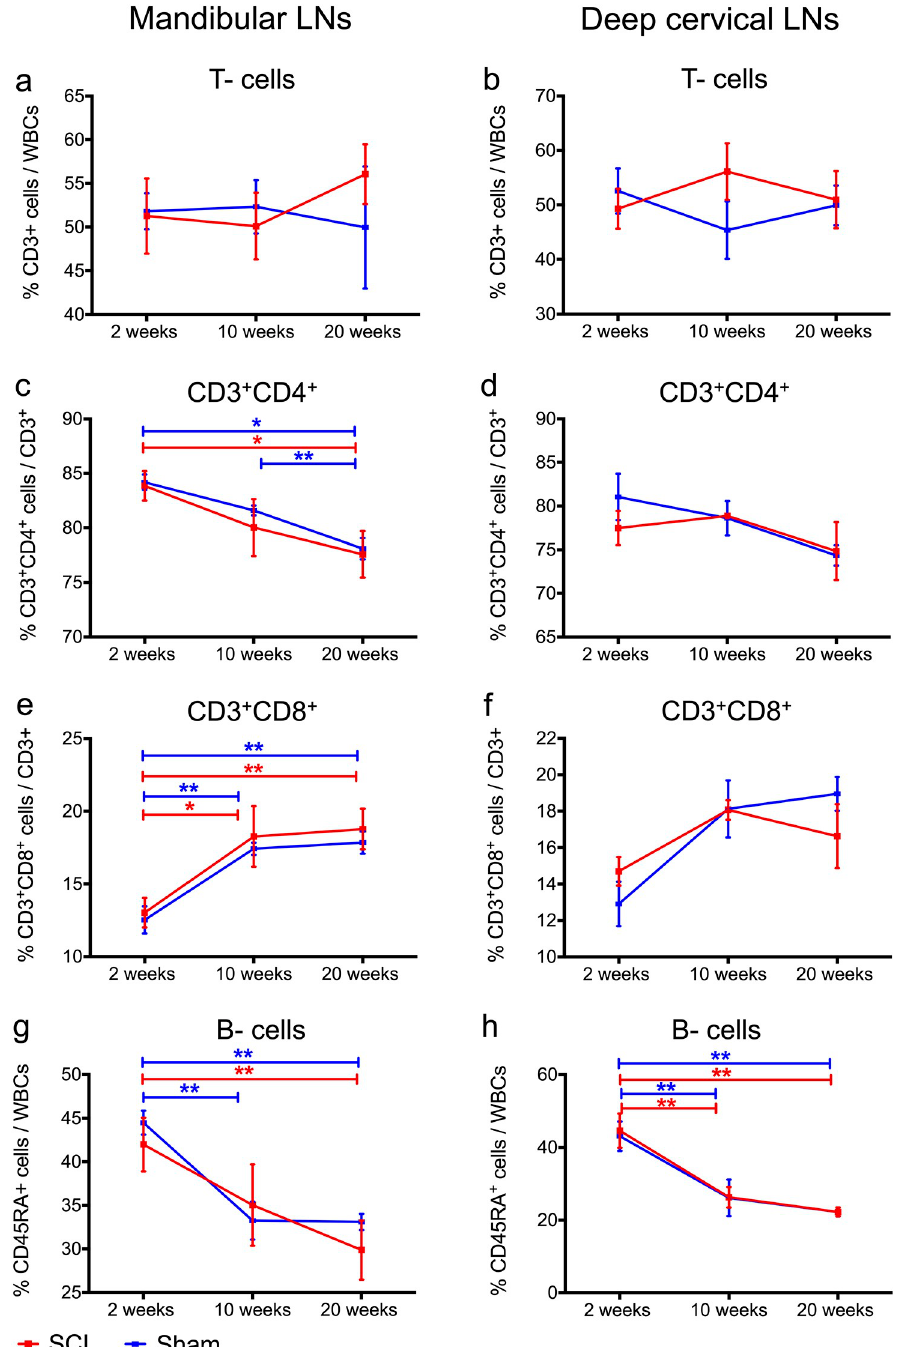
Fig 3. No significant changes in lymphocyte frequencies in the mandibular and deep cervical LNs following cervical SCI. (a-b) T-cell frequencies were similar between rats with cervical SCI and sham injury in both LN types, and these frequencies did not change with timing after injury. (c-d) CD4 + T-cell frequencies were similar between rats with cervical SCI and sham injury in both LN types. (c) In mandibular LNs, CD4 + T-cells decreased significantly with time post injury in both injury groups, and post-hoc tests revealed a significant difference from 2 to 20 weeks for the cervical SCI and sham group, and from 2 to 10 weeks for the sham group. (e-f) CD8 + T-cell frequencies were similar between cervical SCI and sham groups in both LN types. (e) In mandibular LNs CD8 + T- cells increased significantly with time post injury in rats with cervical SCI and sham injury, especially from 2 to 10 weeks and from 2 to 20 weeks post injury. (g-h) B- cell frequencies were similar between the cervical SCI and sham groups in both LN types.